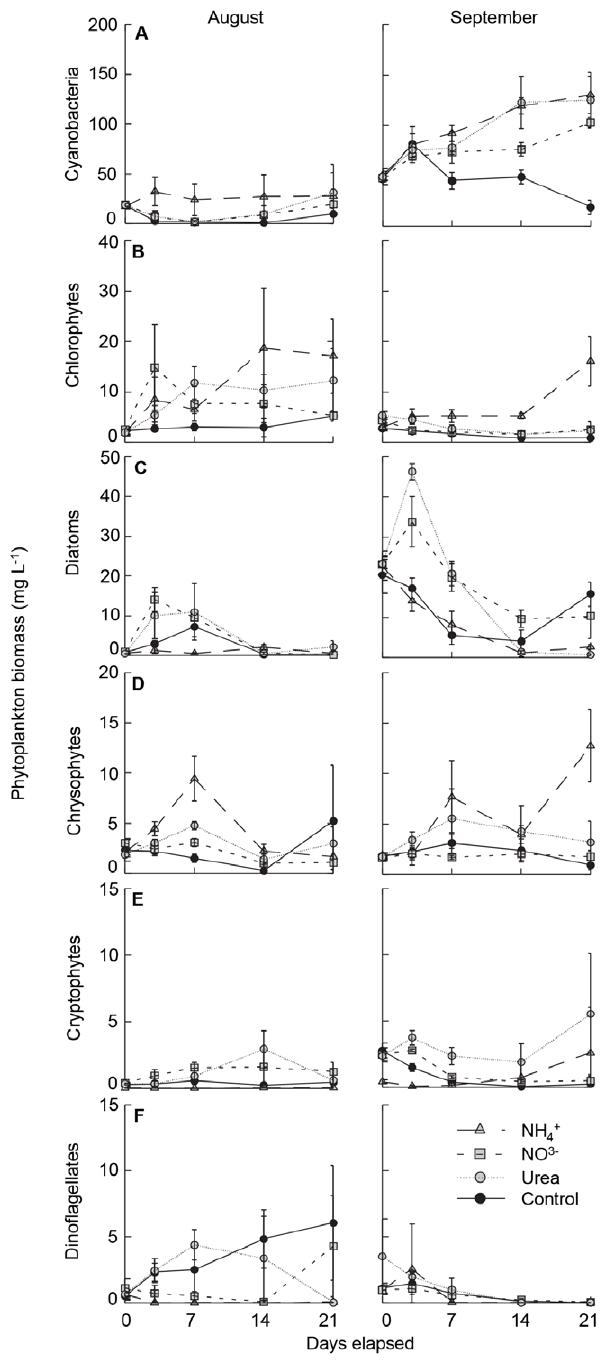
Figure 3. Biomass responses of major phytoplankton groups to fertilisation with nitrogen in mesocosms conducted in August and September. Algal groups (mg wet mass L 2 1 ) include; a) cyanobacteria, b) chlorophytes, c) diatoms, d) chrysophytes, e) cryptophytes and f ) dinoflagellates. Symbols represent mean and standard errors ( 6 SE, n =3) for each of the nitrogen treatments, included amendments with NH 4 + (shaded triangle, coarse dashed line), NO 3 2 (shaded square, medium dashed line) and urea (shaded circle, fine dashed line), as well as unamended (control) mesocosms (solid circle, solid line).